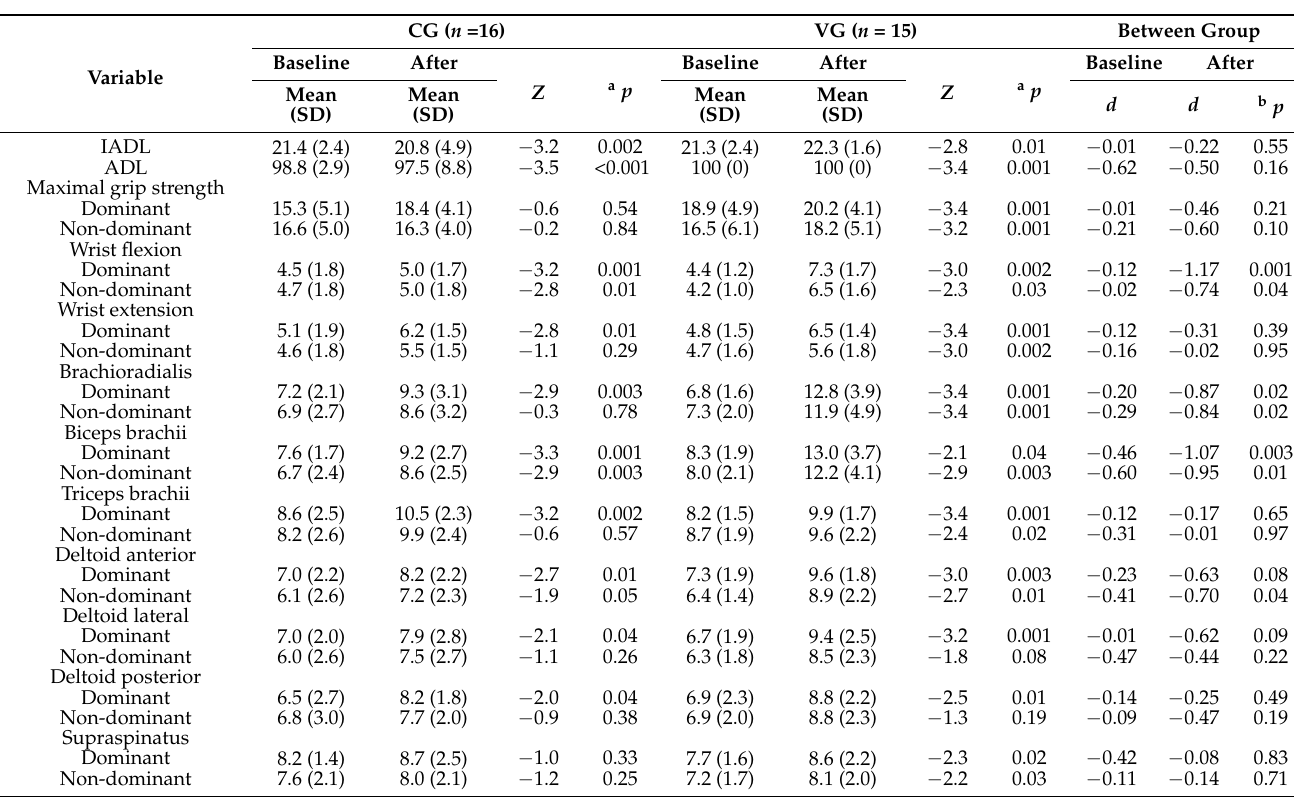
Table 2. Comparisons of Outcome Indicators Between Baseline and Post-Intervention in the Control and Vibration Groups.